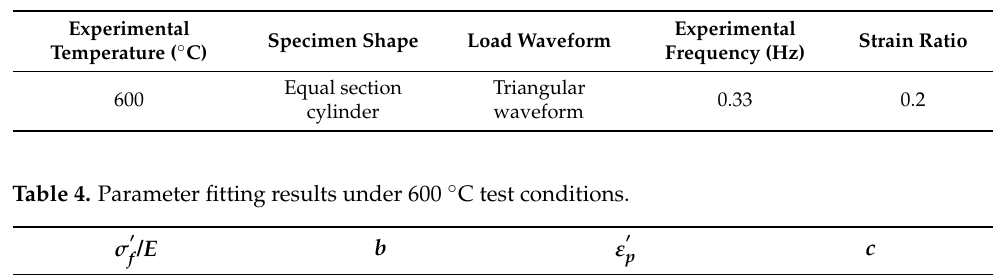
Figure 4. Fitting of plastic parameters when R = 0.2. Table 3. Experimental conditions at 600 ◦ C. Table 4. Parameter fitting results under 600 °C test conditions.